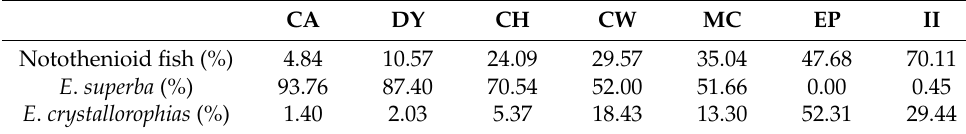
Table 6. Proportions of main prey items by quantitative analysis.